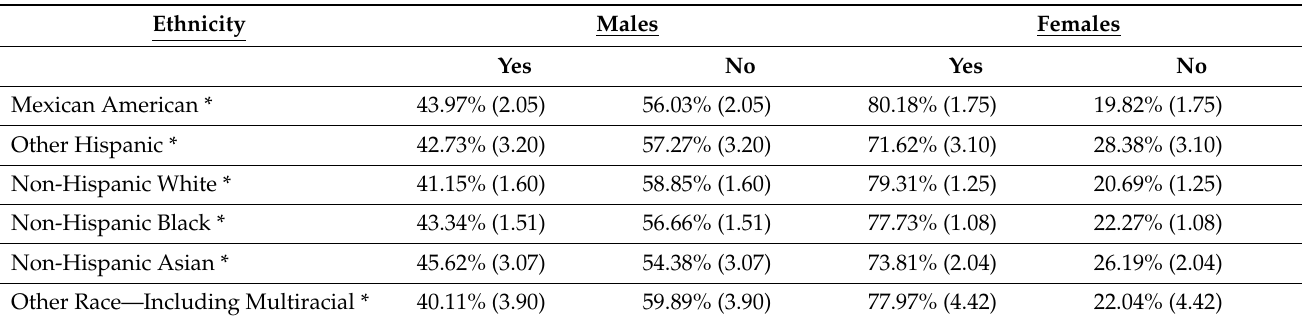
Table 5. Participants’ replies to the question “Are you the person who does most of the shopping for food in family?” stratified by